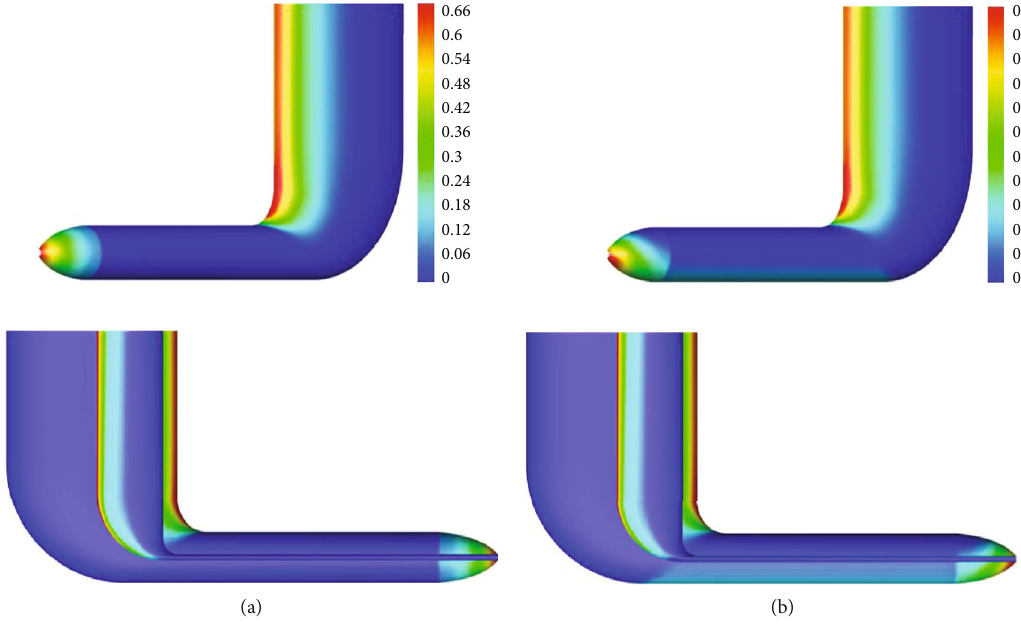
Figure 13: Collection e ffi ciency contour of the pitot-static tube under Case 1 (a) and Case 6 (b).